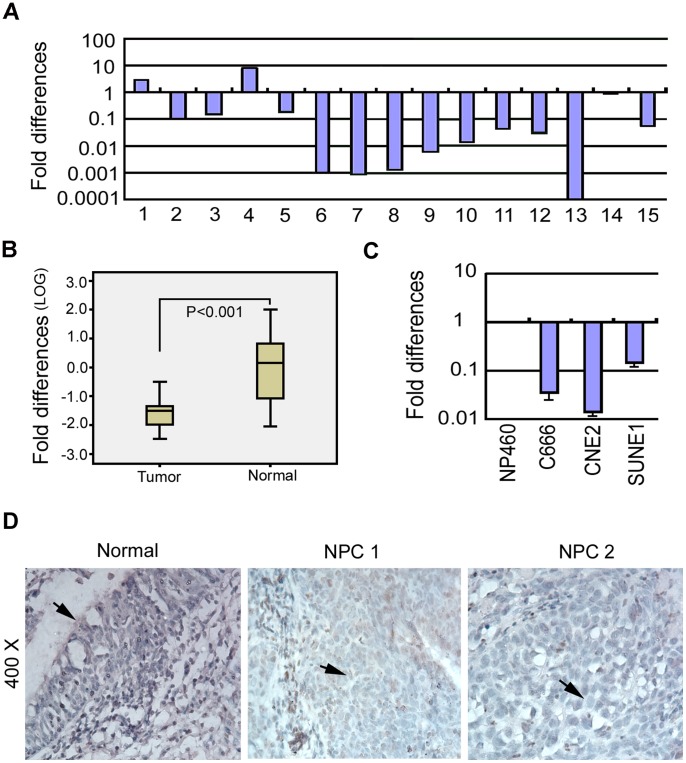
Downregulation of RBMS3 in nasopharyngeal carcinoma (NPC).(A) Expression of RBMS3 in 15 primary NPC cases was compared using qPCR between tumor tissues (T) and their paired normal tissue (N). GAPDH was set as an internal control. (B) RBMS3 expression was normalized by internal control GAPDH. Statistical analysis confirmed the qPCR results (p<0.001). (C) qPCR analysis of RBMS3 expression in three NPC cell lines (C666, CNE2 and SUNE1). The fold changes of RBMS3 expression were compared with the immortalized NP cell line, NP460. (D) Immunohistochemical detection of RBMS3 protein in NPC tissue samples and non-tumor nasopharyngeal tissues. Normal: strong positive staining for RBMS3 protein in normal nasopharyngeal epitheliums (arrowhead). NPC1: weak positive staining for RBMS3 protein in NPC tissues (arrowhead). NPC2: negative staining for RBMS3 protein in NPC tissues (arrowhead).